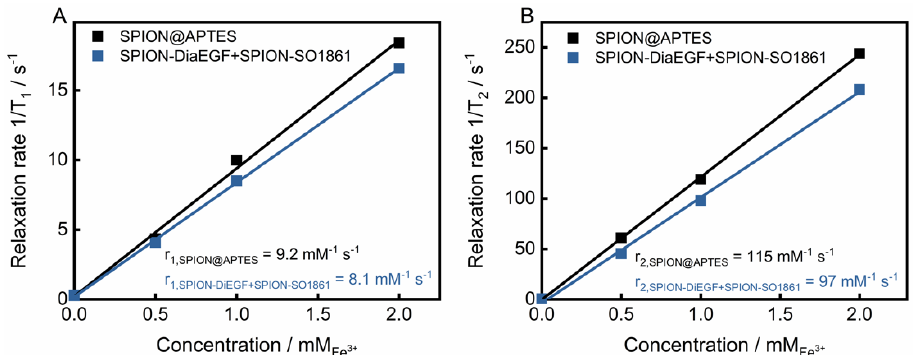
Figure 8. (A ) T 1 and ( B ) T 2 relaxivity measurements of SPION@APTES and the SPION-DiaEGF+ SPION-SO1861 mixture. Values of relaxivites (r 1 and r 2 ) were determined via correlation between the relaxation rates and the corresponding iron concentrations from the slope of the resulting linear regression curve.